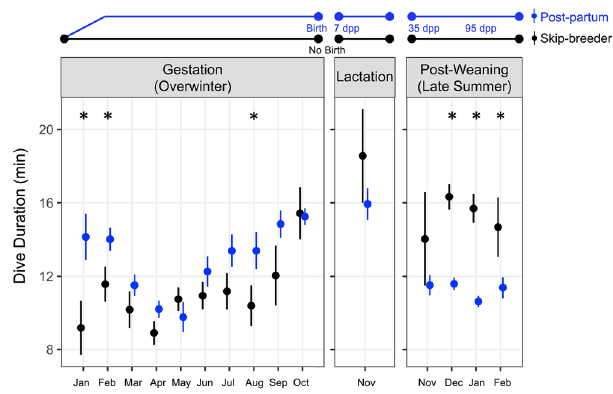
Fig. 6 Year-round changes in skip-breeder and post-partum Weddell seal dive durations. Weighted mean ± SE dive duration of female Weddell seals that were ( left ) instrumented as skip-breeders in years 2010 – 2012. Some females returned after the winter foraging period and gave birth (blue, n = 12) while others failed to produce a pup (black, n = 8); data redrawn from Shero et al. 2018 31 , and are the same seals included in this study. ( Middle ) Dive duration across lactation; skip-breeder value from Shero et al. 2018, lactating female value from Sato et al. 2003 101 ( n = 8). During late- summer ( right ), post-partum females were instrumented at 35 dpp in years 2013 – 2017 and dive durations decreased during the post-weaning period relative to durations during the lactation period ( n = 40), whereas skip- breeder dive durations did not ( n = 19); data from Beltran et al. 2021 30 and are the same seals included in this study. Only animals with >50 dives per month were included in the weighted mean. Generalized Additive Mixed- effect Models were used to test for signi fi cance; Asterisk = signi fi cant difference between reproductive